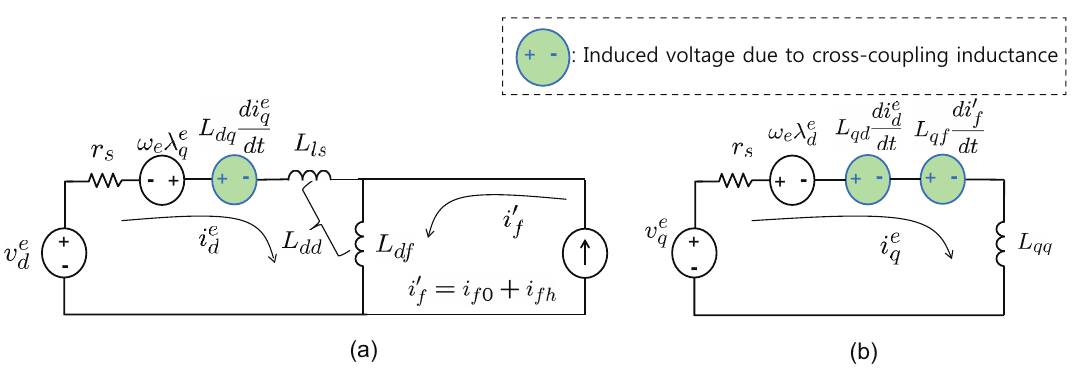
Figure 2. Equivalent circuit of the WSM including cross-coupling inductance: ( a ) d -axis and ( b ) q -axis.